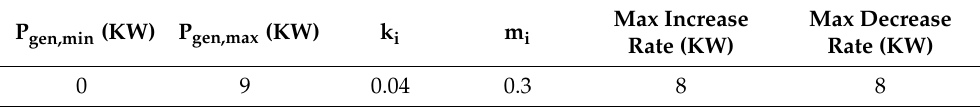
Table 5. Conventional generator